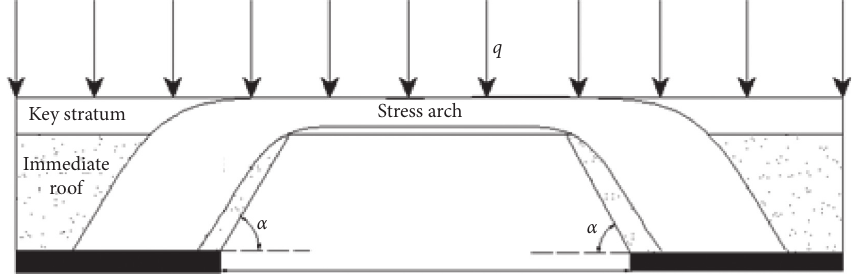
Figure 4: Sketch of major principal stress in key stratum. Table 2: Rock formation columnar section of #13 coal seam in Xiegou coal